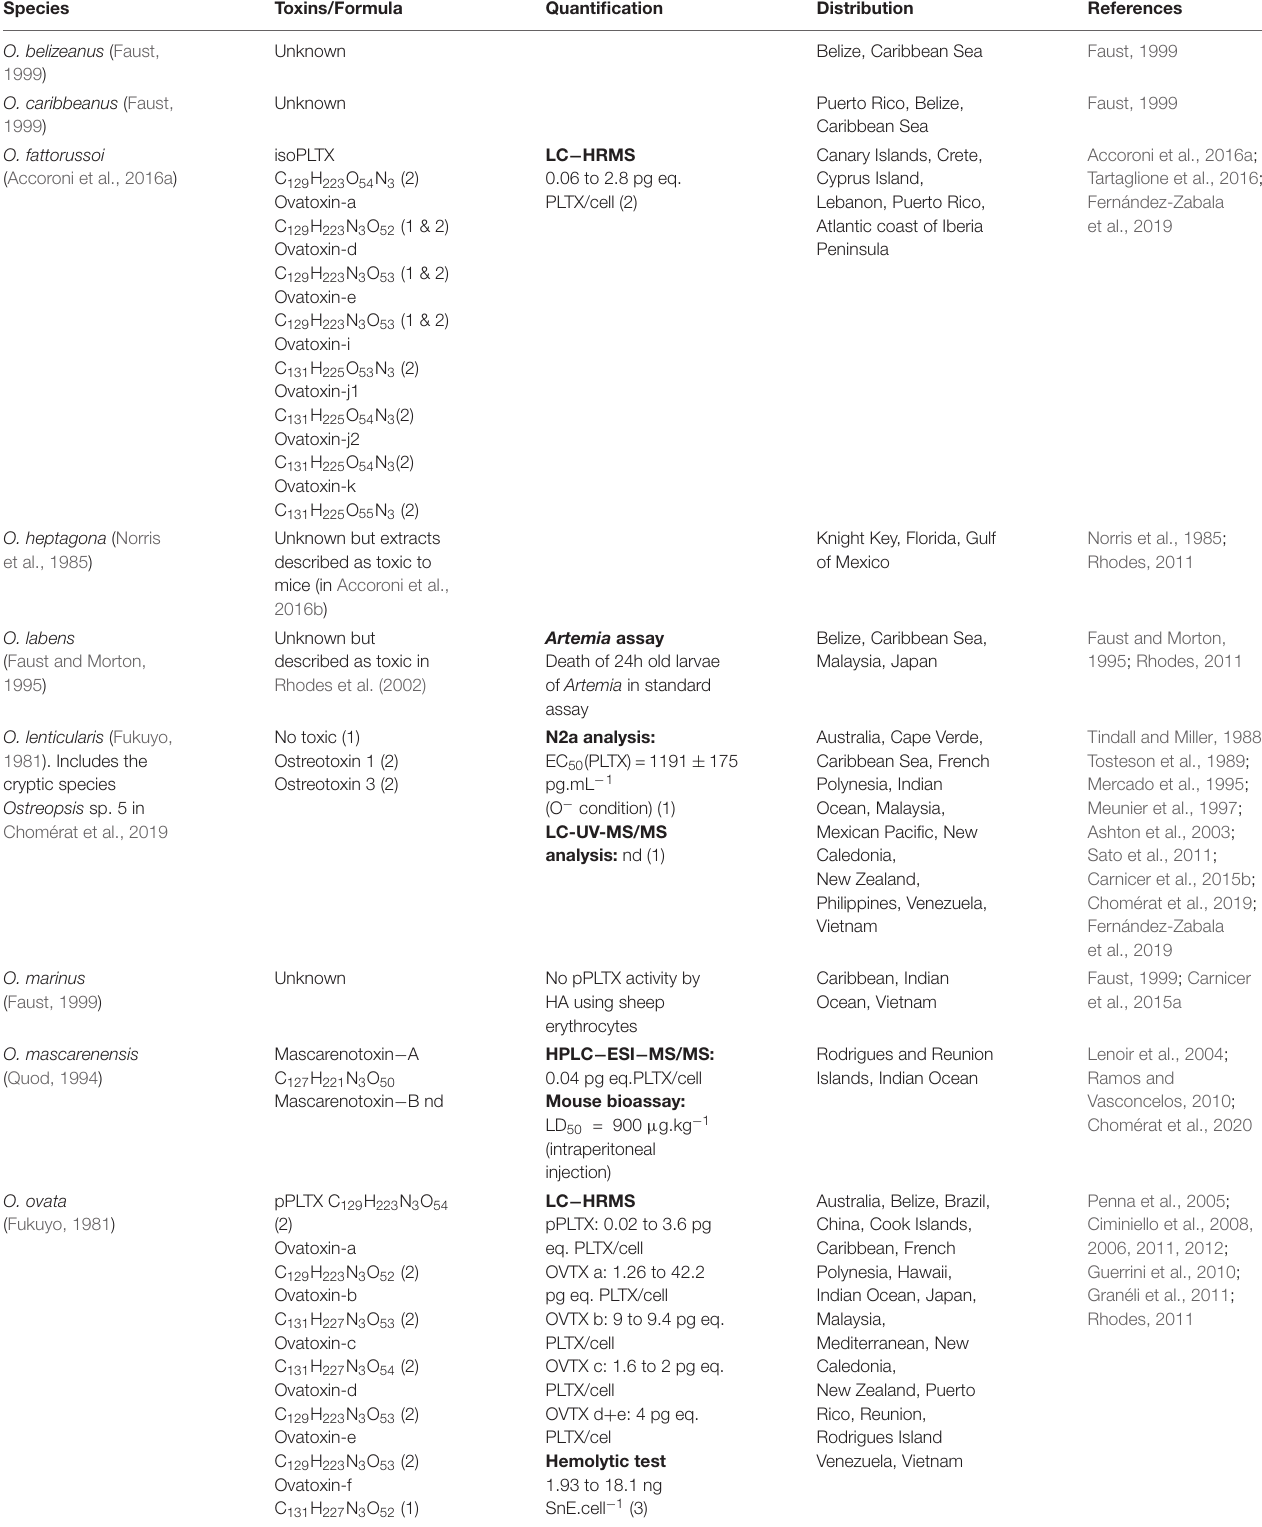
TABLE 1 | Representative information about the range of toxin content on Ostreopsis species from different locations reported in the literature.